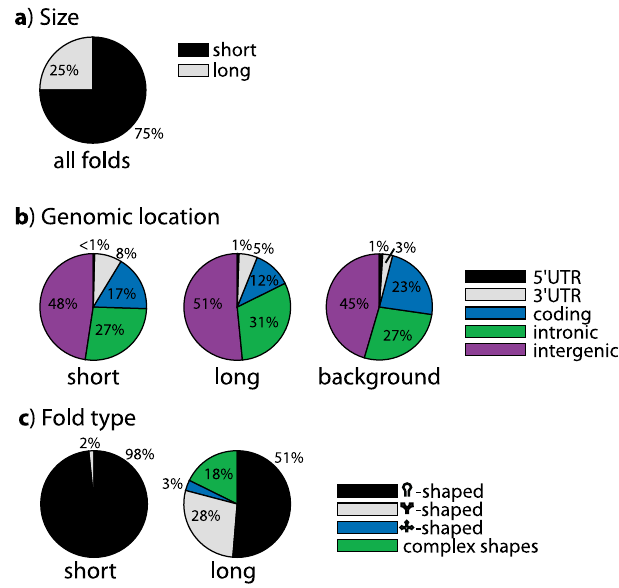
Figure 2. Breakdown of Types of RNA Folds Detected in the Human Genome Based on True Positive Estimates See Materials and Methods, Validation section. Folds are classified according to (A) size (number of pairing bases), (B) location in the genome, and (C) shape. The relative abundance of each class of folds is indicated. For (B), also shown is the genomic span of the conserved segments relative to their genomic location, for comparison. DOI: